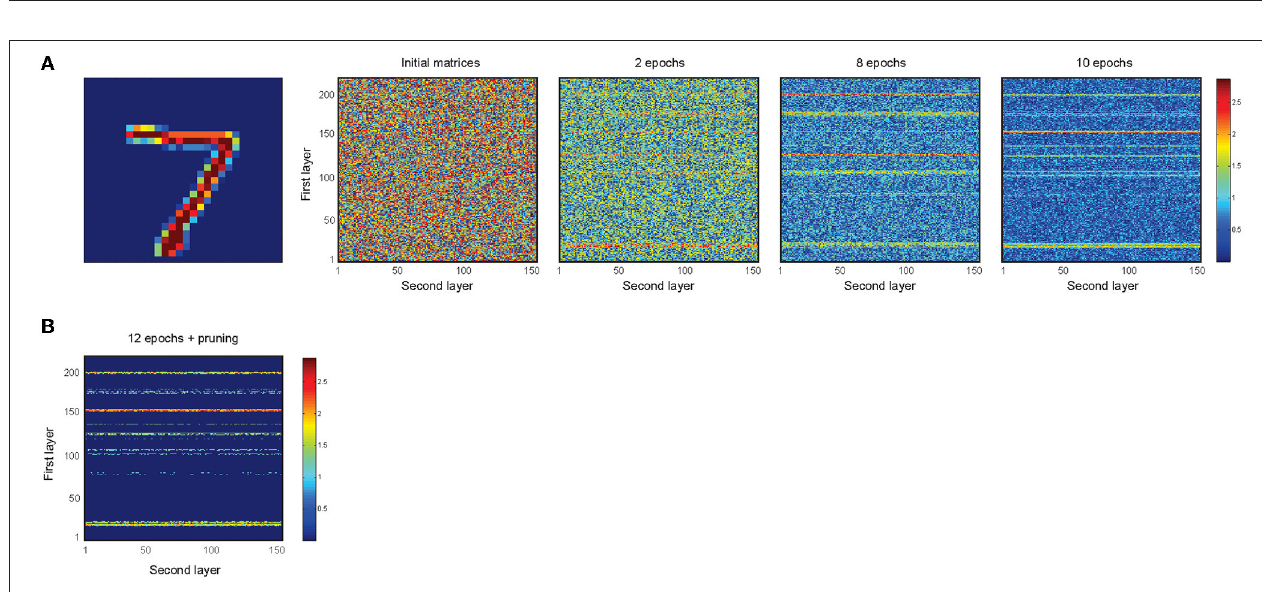
FIGURE 5 | probability of the inhibitory neuron on parameter value. (D) Lower inhibition parameter values induce higher inhibition on the neural spiking of the first layer that results in a lower distance between the neuronal representations. Two cases are considered: images are used either before or after preprocessing. For each data point, 200 pairs of images per digit class were randomly selected from the training dataset. (E) Average classification accuracy using different inhibition parameter values on the entire test data. The right panel shows the results of the mean classification accuracy of all digit classes using 40 “selected training samples” per digit